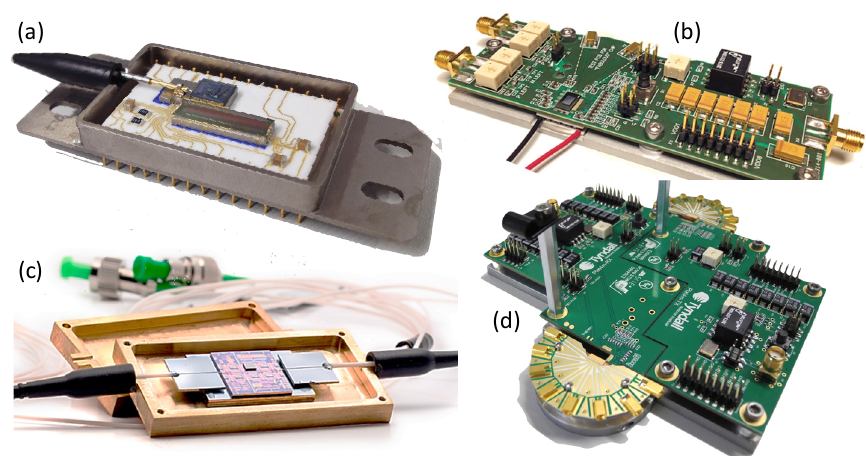
Figure 2. Examples of packaged photonic modules; ( a ) Single ‐ channel PIC with side ‐ by ‐ side electronic integration; ( b ) Optical Network Unit (ONU) of the FP7 ‐ FABULOUS project; ( c ) Single ‐ channel in/out photonic module with vertically integrated electronic chip; ( d ) 8 ‐ Channel Transceiver for the FP7 ‐ PLAT4M project.